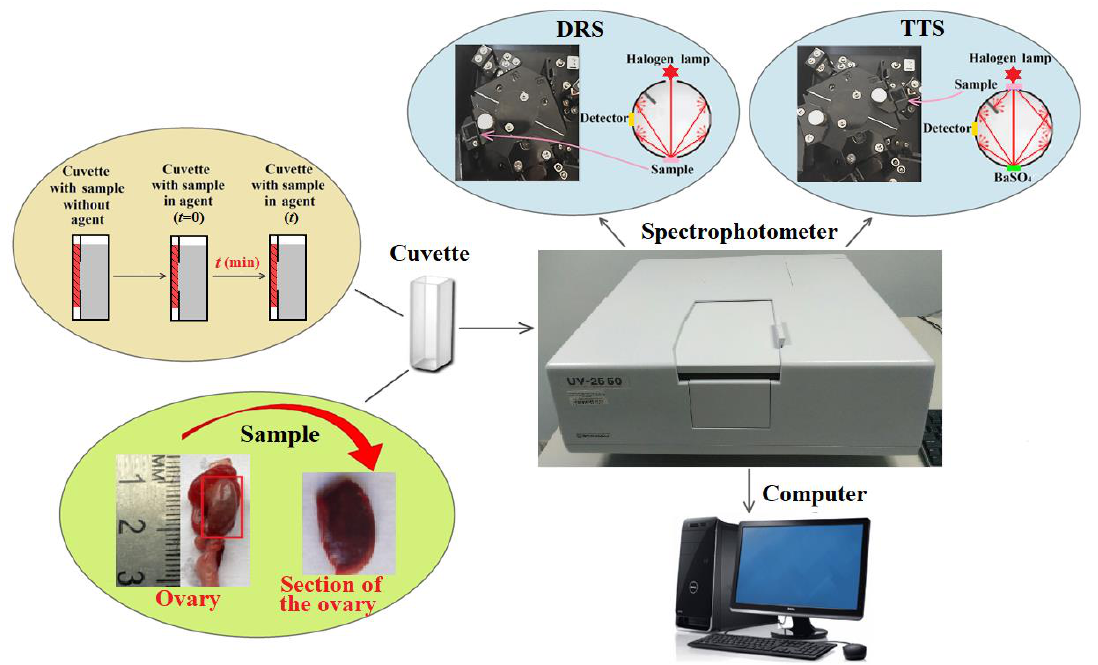
Figure 3. Scheme of the experimental setup for measuring the DRS and TTS of ex vivo samples of cat ovarian tissue.